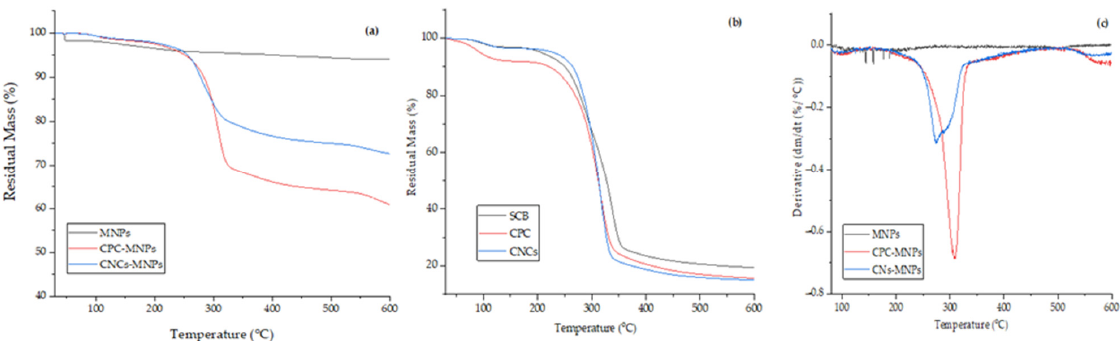
Figure 5. TGA curves for ( a ) MNPs, CPC-MNPs, and CNC-MNPs; ( b ) SCB, CPC, and CNC. DTG curves for ( c ) MNPs, CPC-MNPs, and CNC-MNPs.